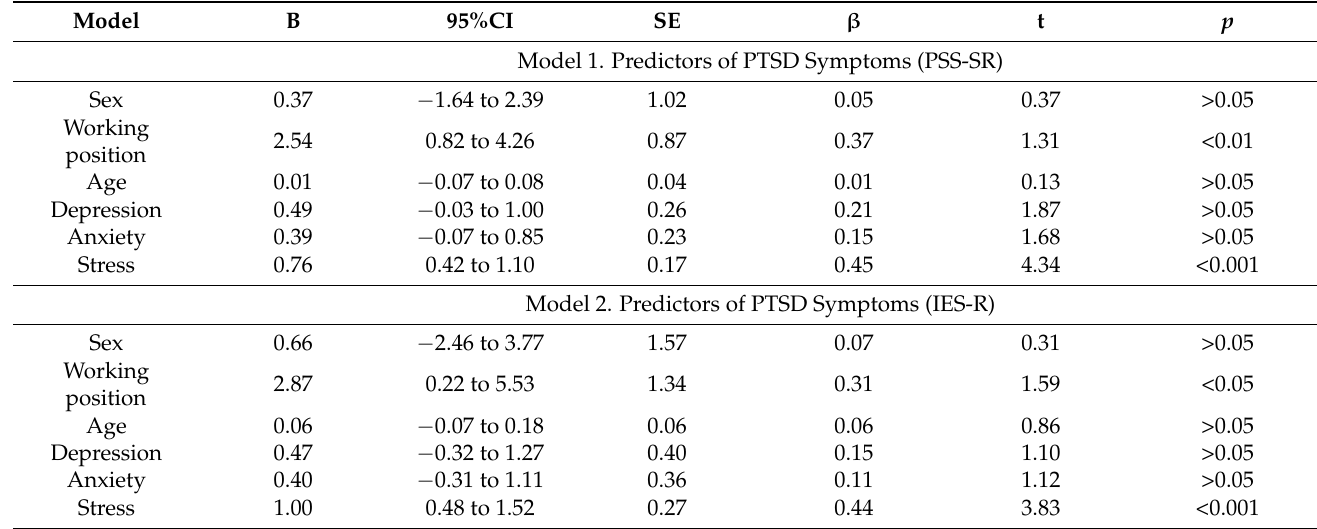
Table 4. The risk factors for PTSD symptoms among healthcare